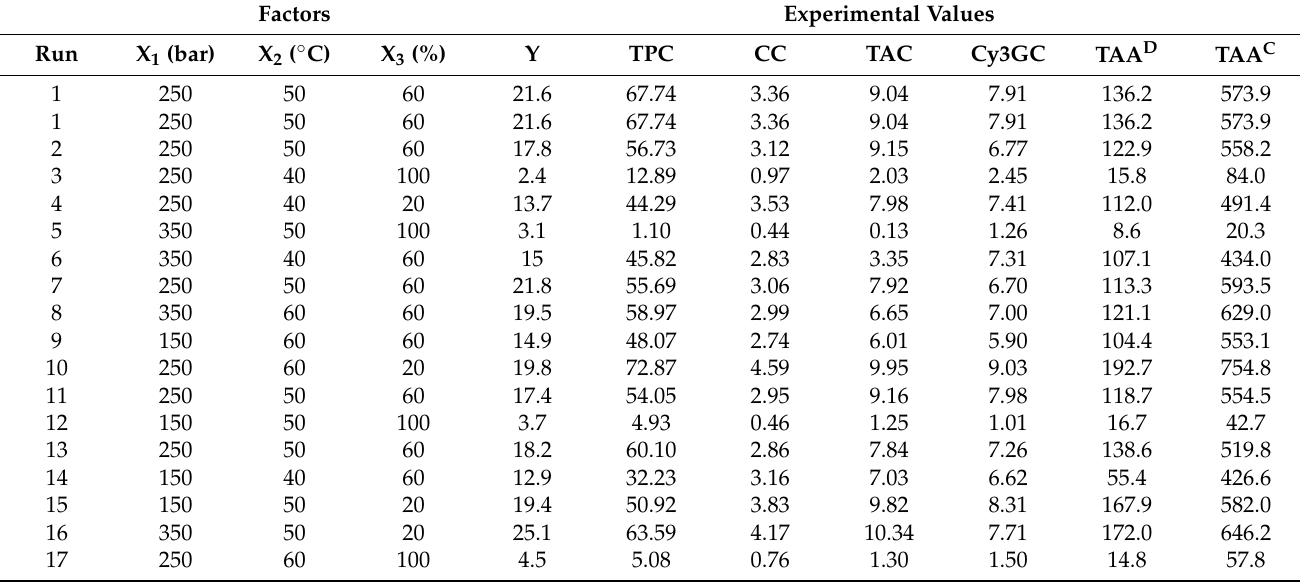
Table 1. Experimental conditions and responses obtained defined by the BBD design matrix for the extraction yield, phenolic-, anthocyanin content, and antioxidant activity in black rosehip. Factors Experimental